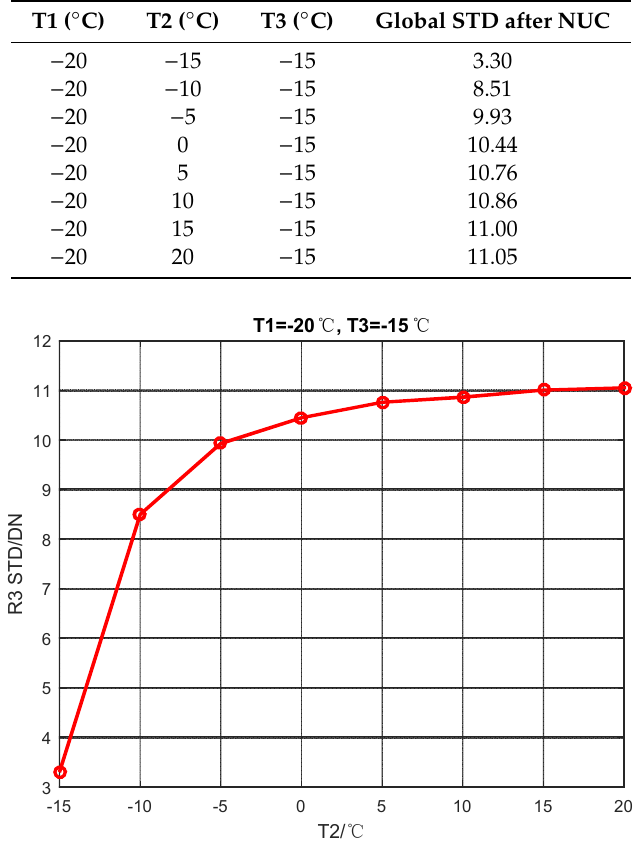
Figure 7. Global STD after NUC changes with T2.